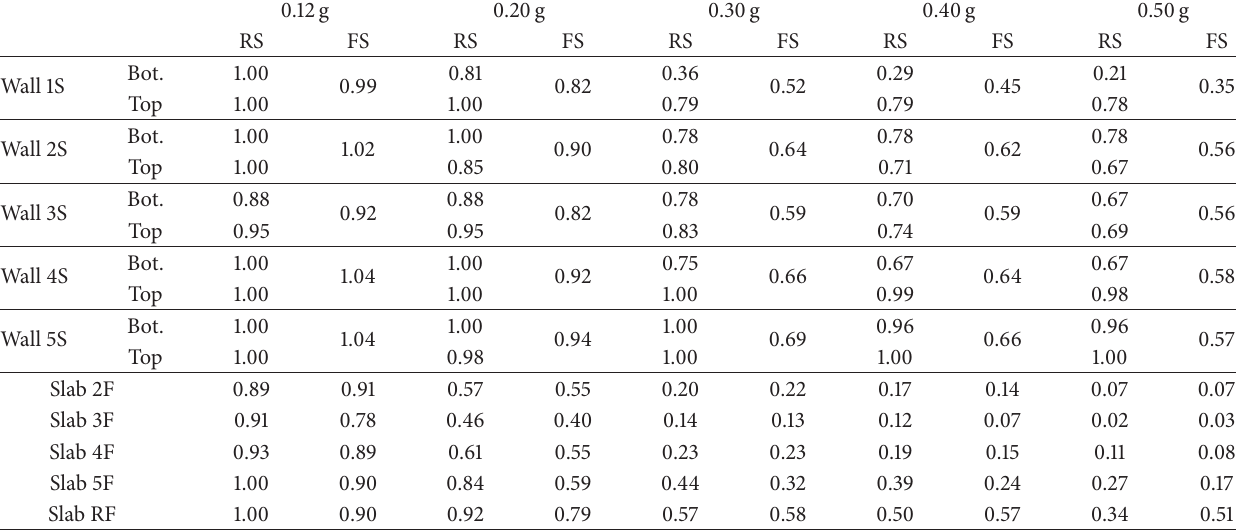
Table 5: Updated parameters normalized with those of undamaged